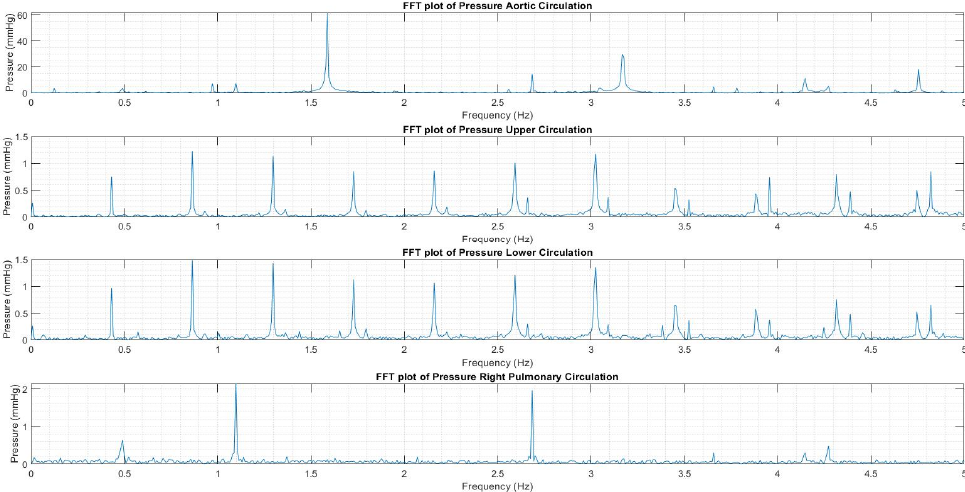
Figure A2. FFT on pressure waveform for the 3 mm IJS experiment.